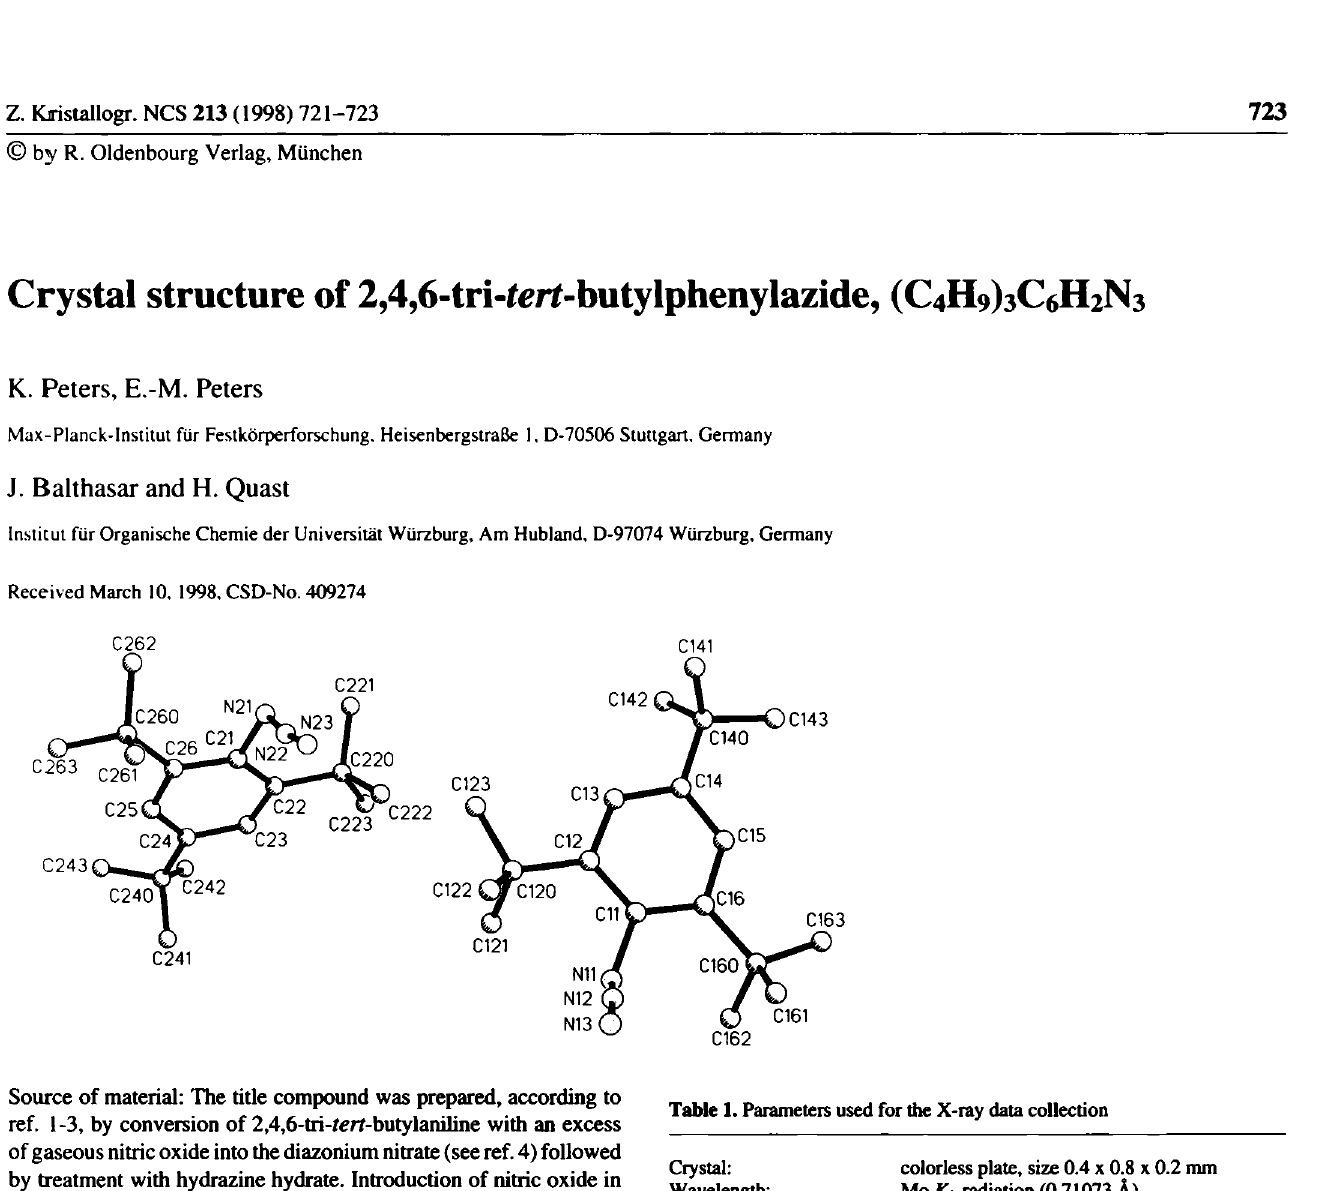
Table 1. Parameteis used for the X-ray data collection Crystal: